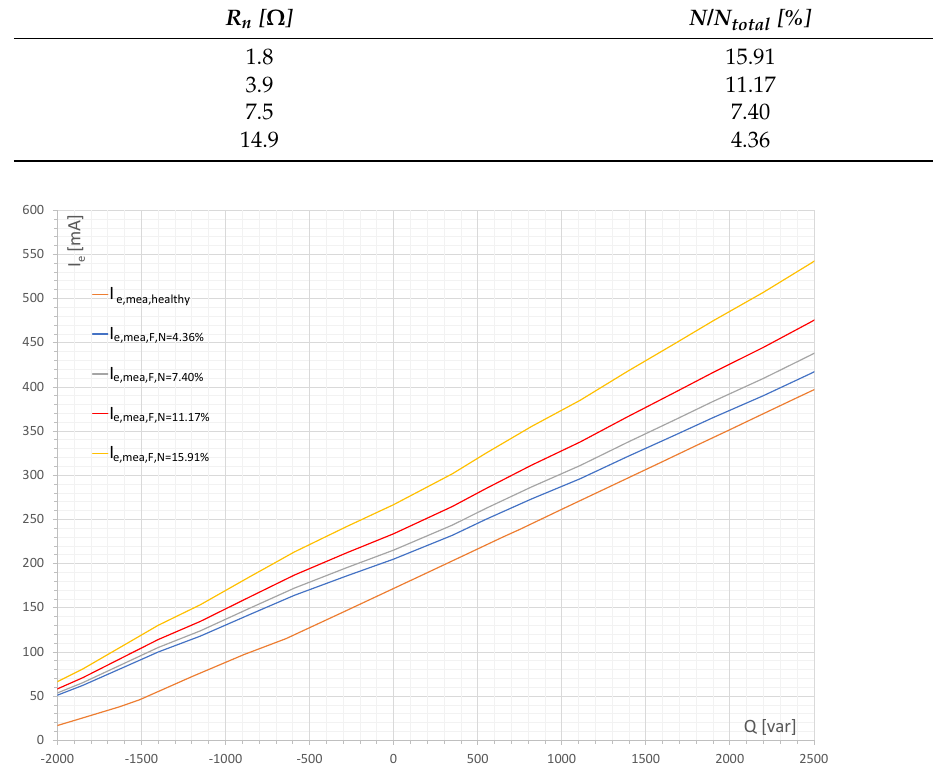
Figure 18. Exciter field current measurements for [ P = 1000 W, Q ], at fixed output voltage ( U = 385 V ) in healthy and main field winding interturn fault conditions.